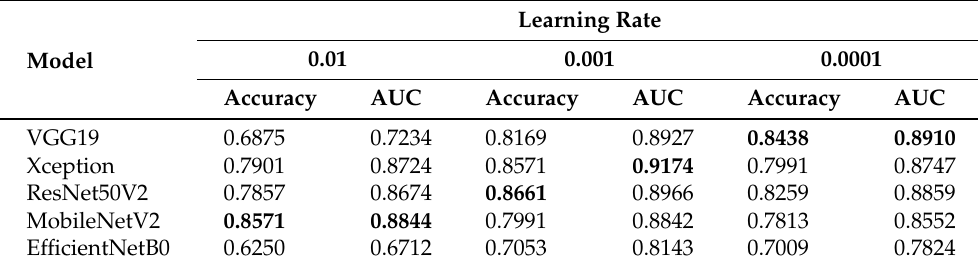
Table 4. Model performance for different learning rates.